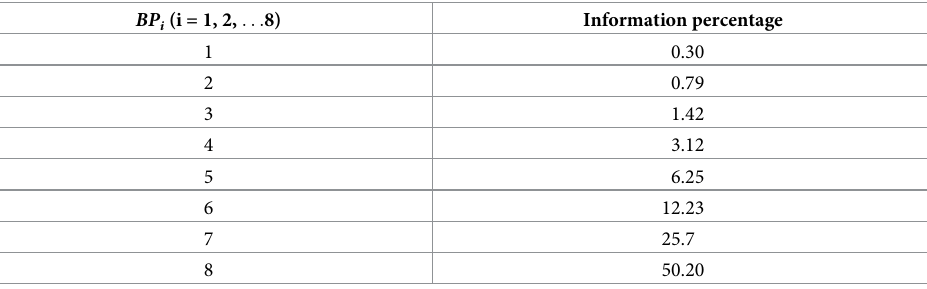
Table 2. Information